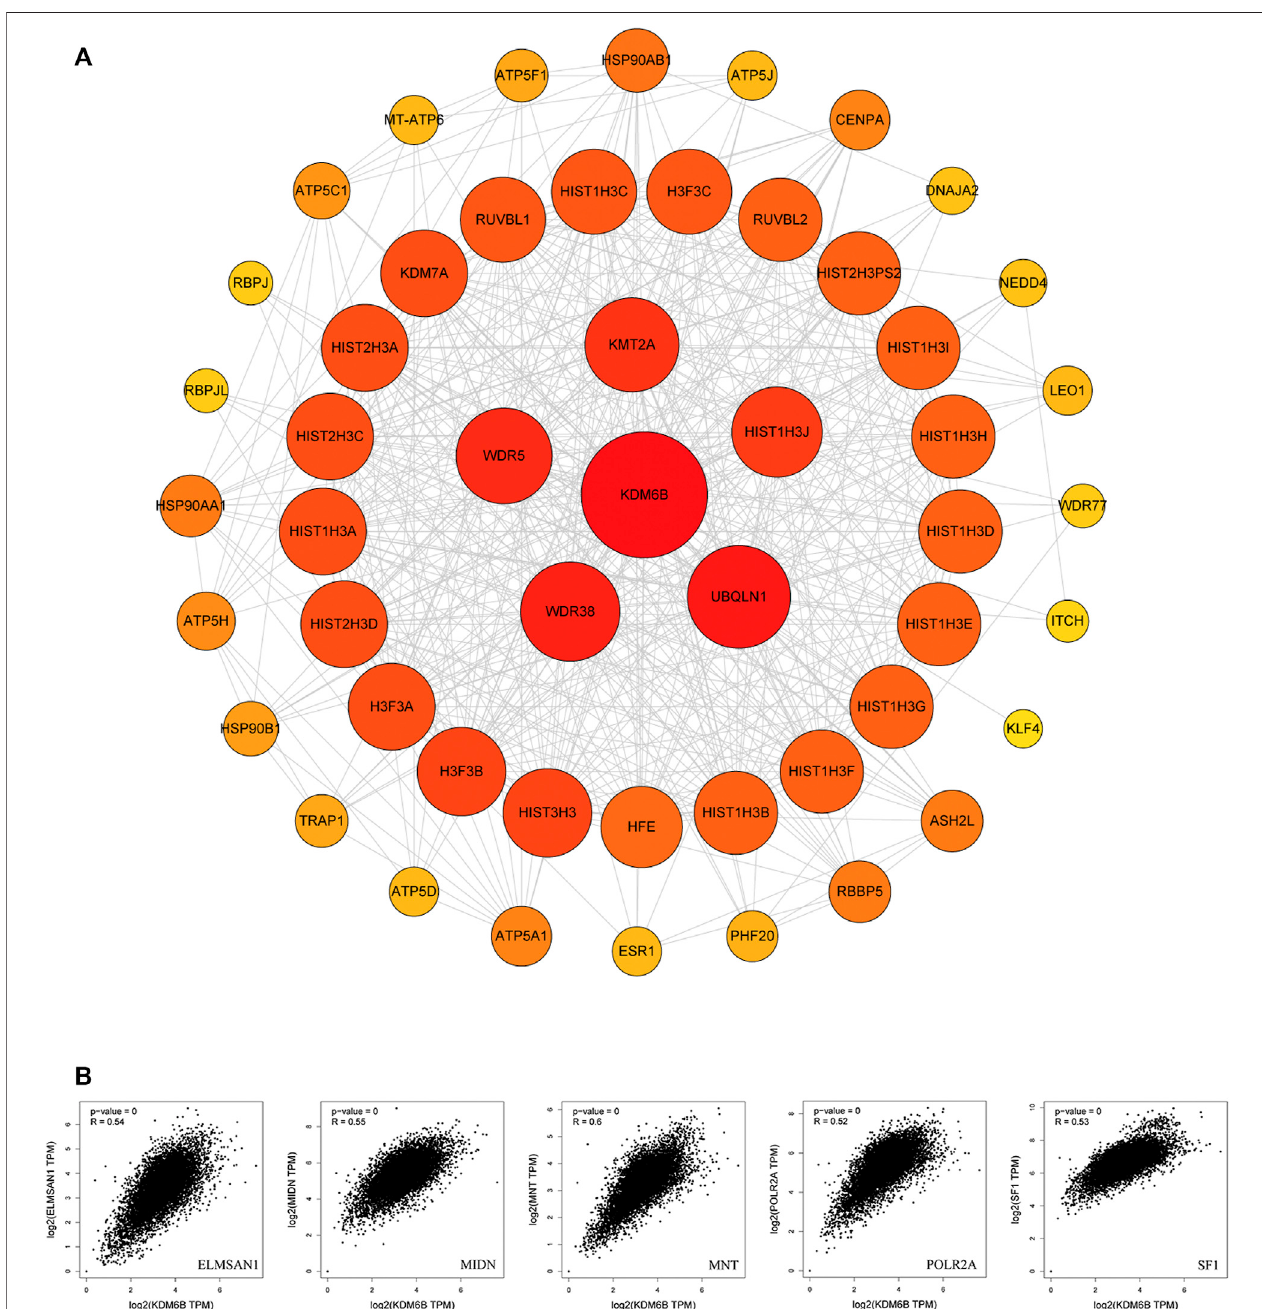
FIGURE 7 | KDM6B-related gene enrichment analysis. (A) Protein – protein interaction (PPI) network of the top 50 available experimentally determined KDM6B- binding proteins obtained from the STRING website. (B) Using the GEPIA2 approach, we also obtained the top 100 KDM6B-correlated genes in TCGA projects and analyzed the expression correlation between KDM6B and related genes, including ELMSAN1 , MIDN , MNT , POLR2A , and SF1 .